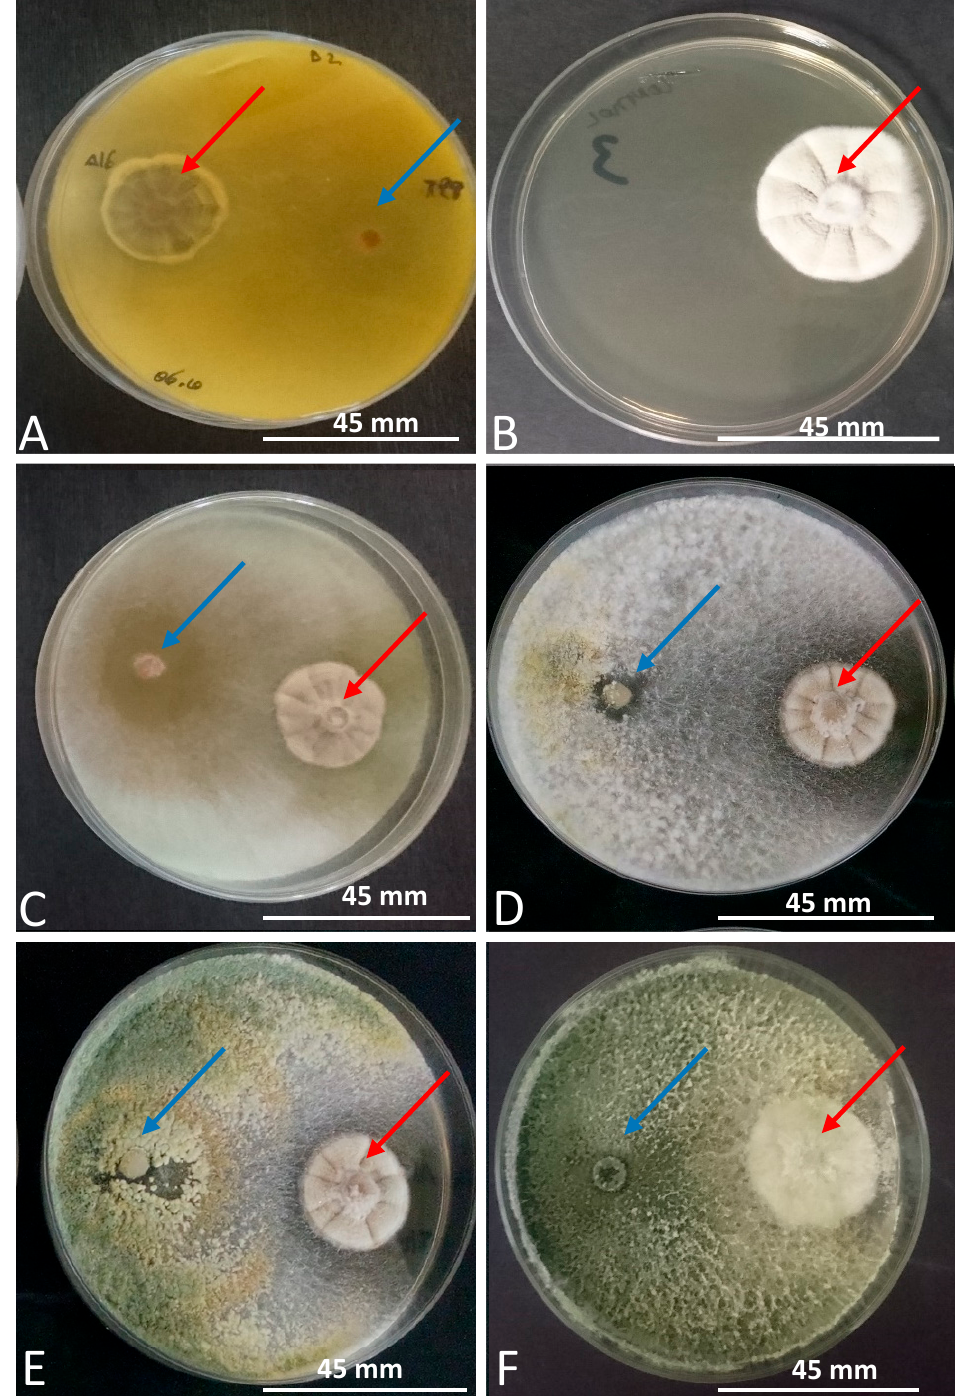
Figure 1. Dual culture evaluations of Trichoderma spp. (blue arrow) and P. minimum (red arrow) in Petri dishes with potato-dextrose-agar medium (PDA) after 5 days of co-culture. ( A ) Trichoderma isolate (T79) that produces yellow pigmentation. ( B ) P. minimum control plate. ( C ) Degree 0 of sporulation (T106) in dual confrontation (absence). ( D ) Degree 1 of sporulation in dual confrontation (weak) (T85). ( E ) Degree 2 of sporulation (T138) in dual confrontation (heavy). ( F ) Degree 3 of sporulation (T154) in dual confrontation (very heavy).